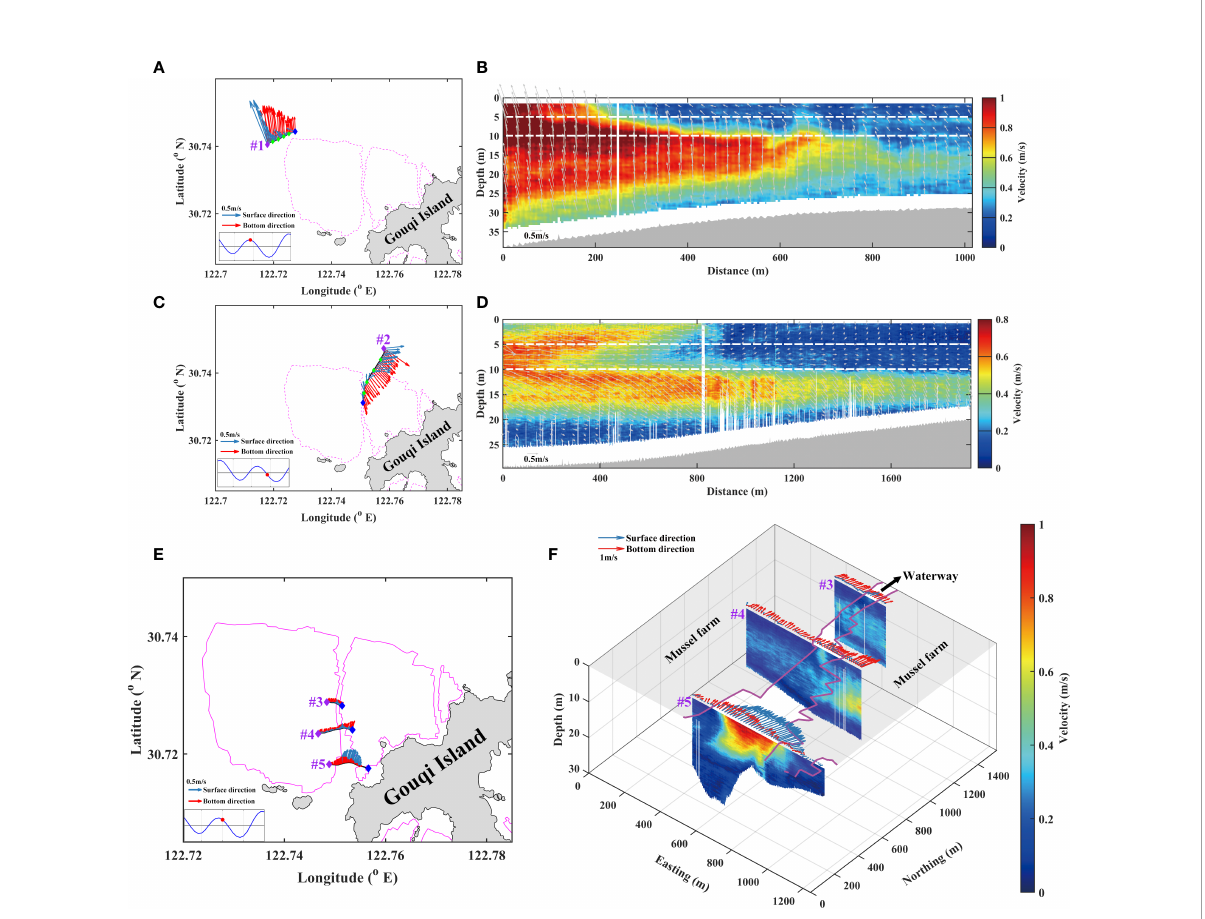
FIGURE 4 Observed vertical pro fi les of fl ow for transect lines #1, #2, #3, #4 and #5 collected by ADCP mounted to a boat. Pink lines indicate the borderlines of mussel farms. The insert plot is the time series of tidal elevation at Shengshan Tide station (122°28 ′ E,30°43 ′ N) with the red dot indicate the time instant of the tidal elevation. Blue and red arrows show the current vector at the surface and bottom, respectively. The gray arrows in (B, D) indicate the horizontal tidal current vector. The purple and blue diamond is the starting and end point of boat cruises respectively. The green diamonds in (A, C) indicate observation point of 400 meters intervals. (A) Transect line #1 & (C) Transect line #2 & (E) Transect line #3, #4 and #5 location diagram. (B) Vertical current pro fi le along transect line #1 on July 10, 2021 during spring tide. (D) Vertical current pro fi le along transect line #2 on June 29, 2021 during neap tide. (F) Vertical current pro fi le along transect line #3, #4 and #5 on July 10, 2021 during spring tide within 30 minutes for 2 minutes, 4 minutes and 5 minutes,